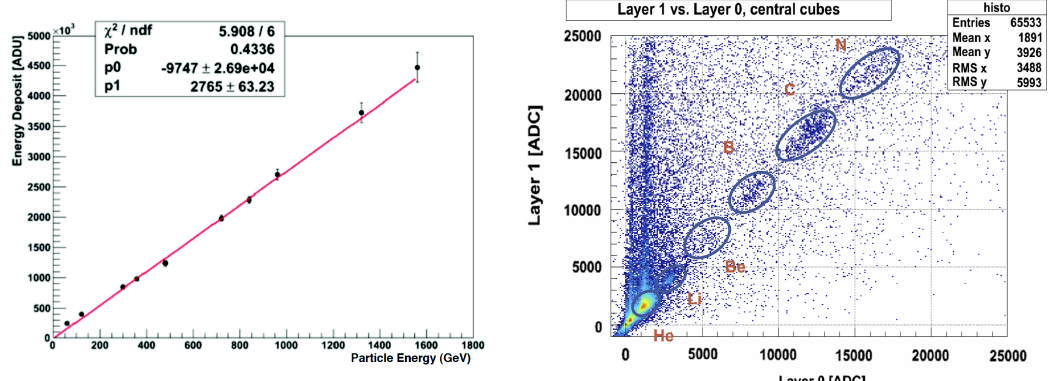
Figure 4. Left panel : Linearity of the response of the prototype to the 30 GeV/n beam as a function of the energy of the various ions; Right panel : Correlation between energy deposited by non-showering particles in the first and second layer of our prototype.